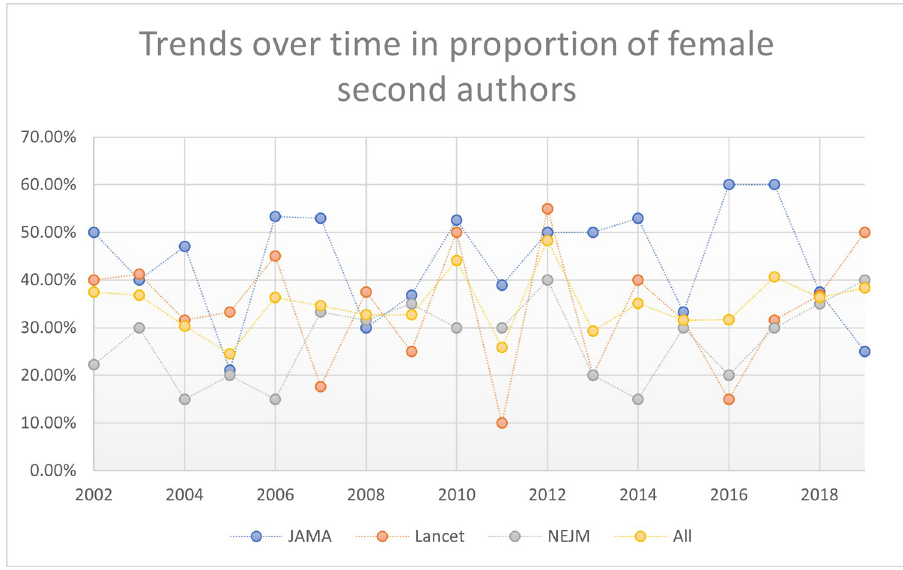
Fig 3. Trends over time in proportion of second authors by